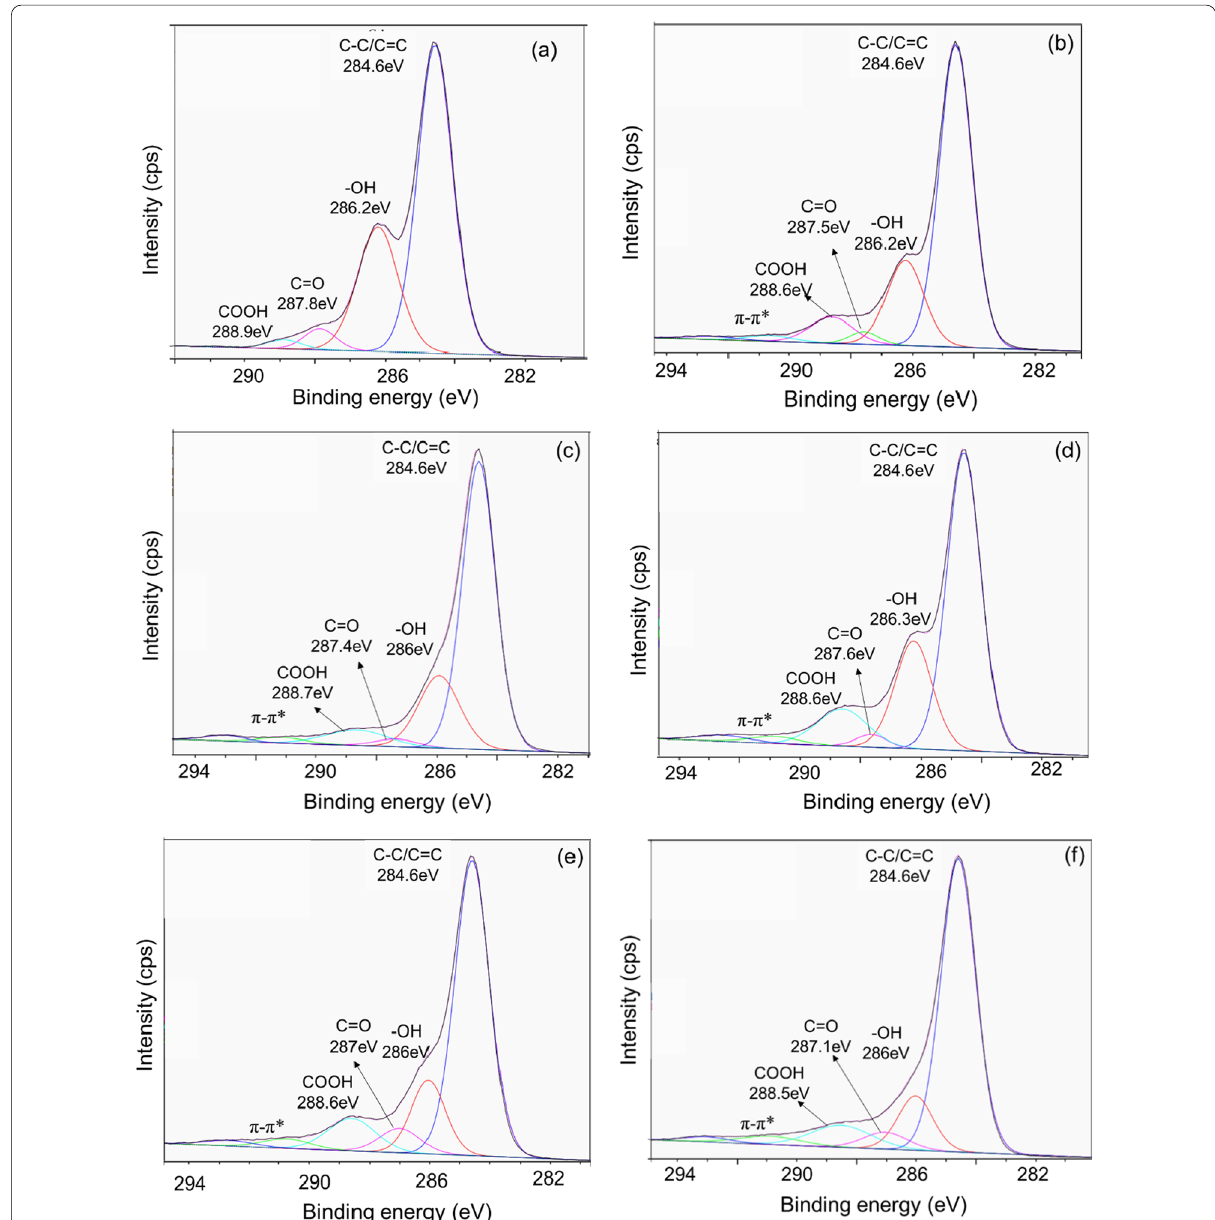
Fig. 4 XPS spectra of as-prepared humic acid (H) and biomass (BM) mix ball-milled materials (BM- or HBM- carbonization temperature in °C) for C 1 s region of ( a ) BM blank, ( b ) HBM blank, ( c ) BM-400, ( d ) HBM-200, ( e ) HBM-300 and ( f )